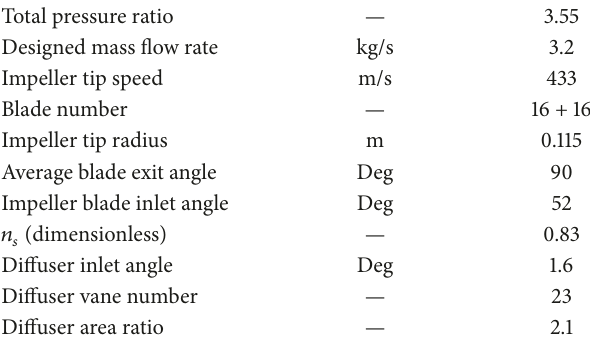
Table 1: Typical design parameters.